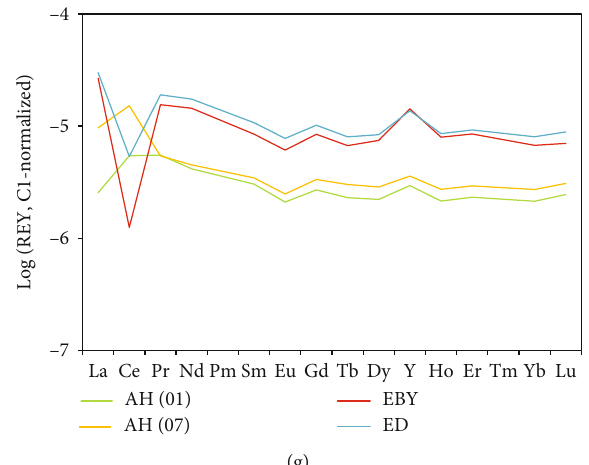
Figure 6: REY distribution patterns of groundwater in the Lower Yarmouk Gorge. The visual grouping of patterns shows their high variability.